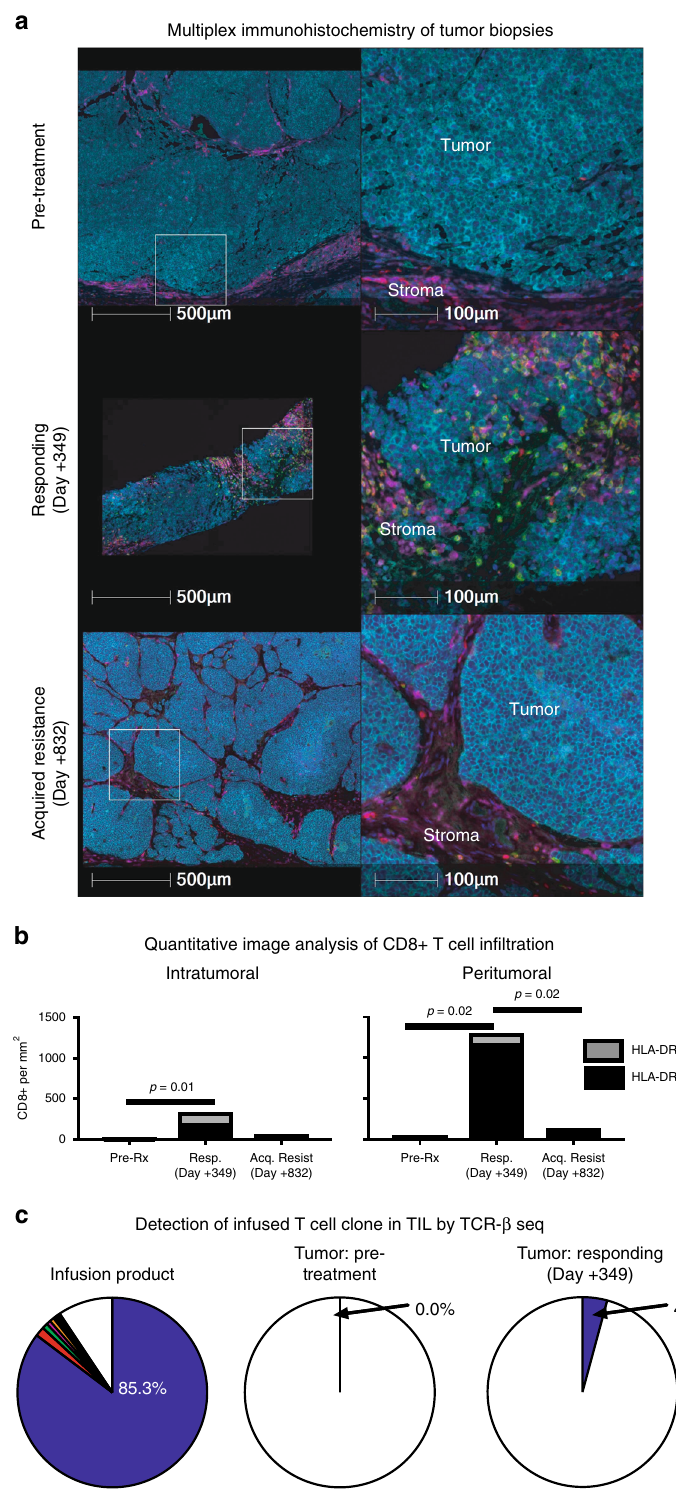
Fig. 3 Activated CD8 + T cell in fi ltration into tumor at the time of treatment response. a Multiplex immunohistochemistry showing representative peritumoral and intratumoral CD8 + in fi ltrates. Arrows indicate CD3 + CD8 + cells (not all indicated). Dark blue = DAPI (nuclei), Light blue = CD56 (MCC tumor), Red = CD3 + CD8 – , Green = CD8 + , Purple = HLA-DR. Three timepoints are shown from the discovery patient (2586-4): pre-treatment, post- treatment response (day + 349), and late/acquired resistance (day + 832). b Quanti fi cation of density of peritumoral and intratumoral CD8 cells. Three representative microscope scan areas were digitally scored for each patient, and signi fi cant differences in density determined with student ’ s T test. c Detection of infused T cell clonotypes in tumor at time of treatment response by sequencing of TCR